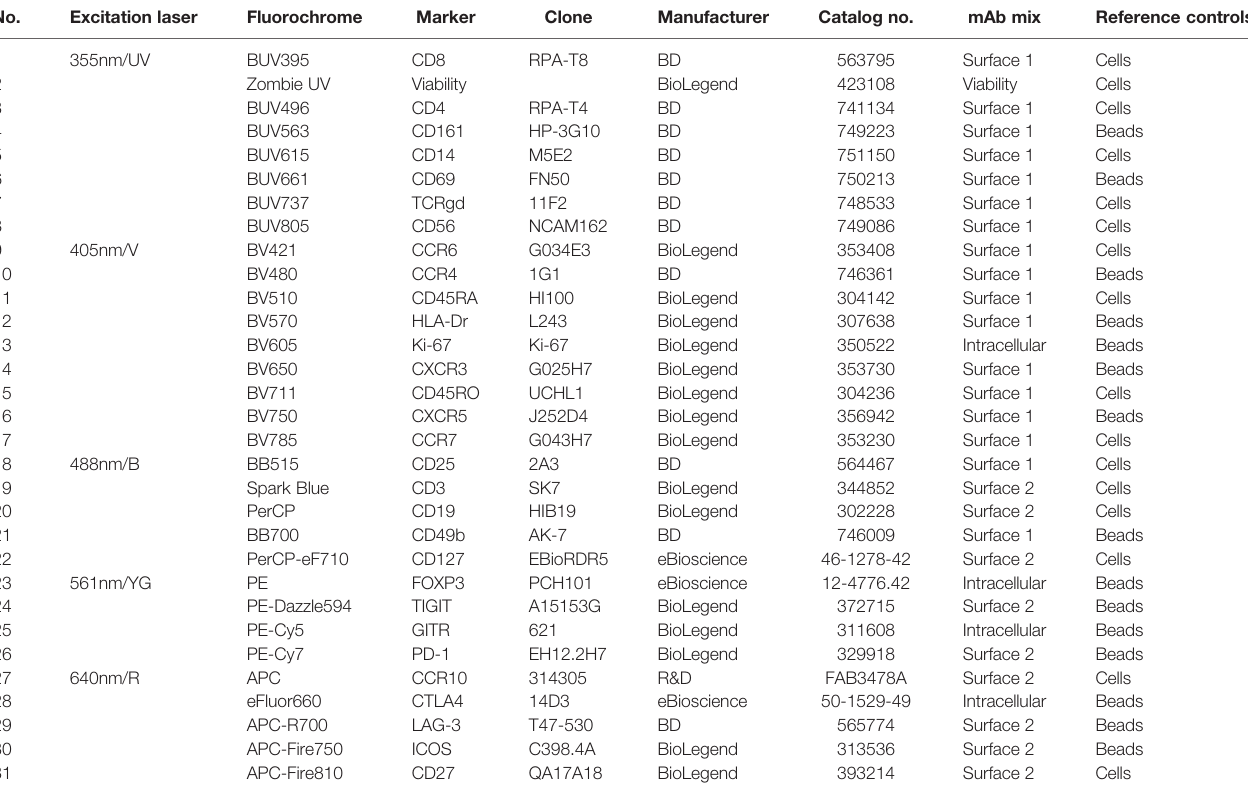
TABLE 1 | List of antibodies and viability dye used in 31-color spectral fl ow cytometry panel.